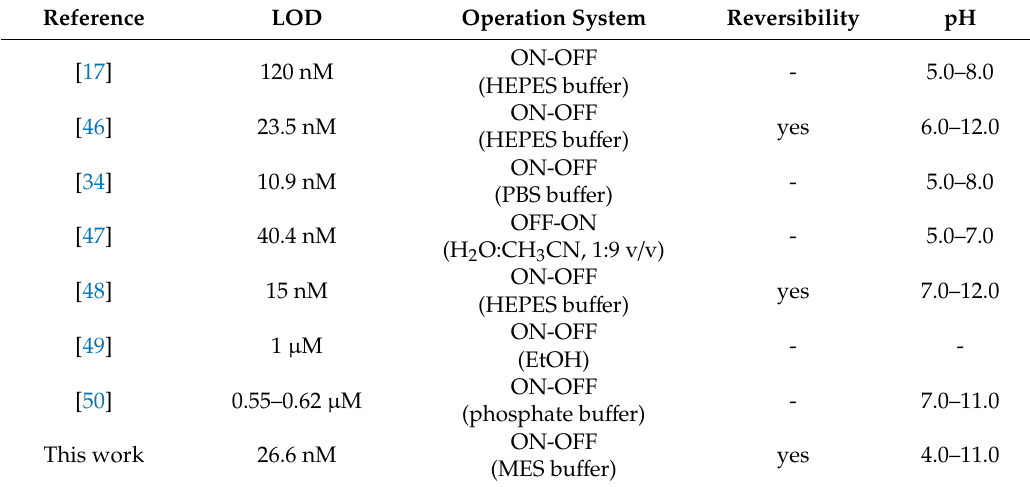
Table 2. Comparison of some recent fluorescent sensors for Cu 2 +